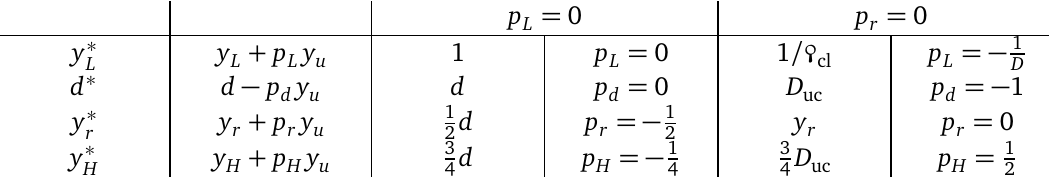
Table 2: Modified scaling powers for the (long-range) Ising model when choosing = 0 or p = 0 respectively. The choice p p L r power of the inverse system size invariant, while the choice p power of the characteristic length scale invariant.